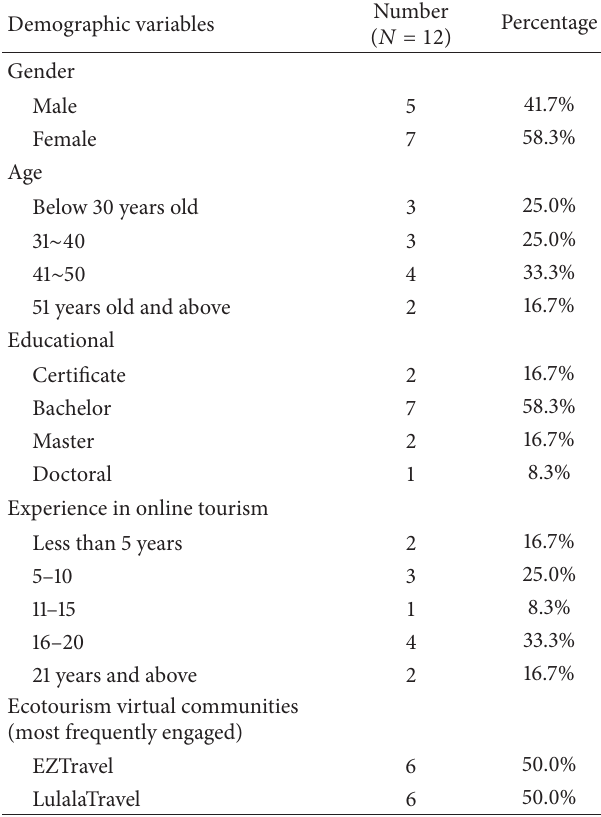
Table 2: The demographic variables of 12